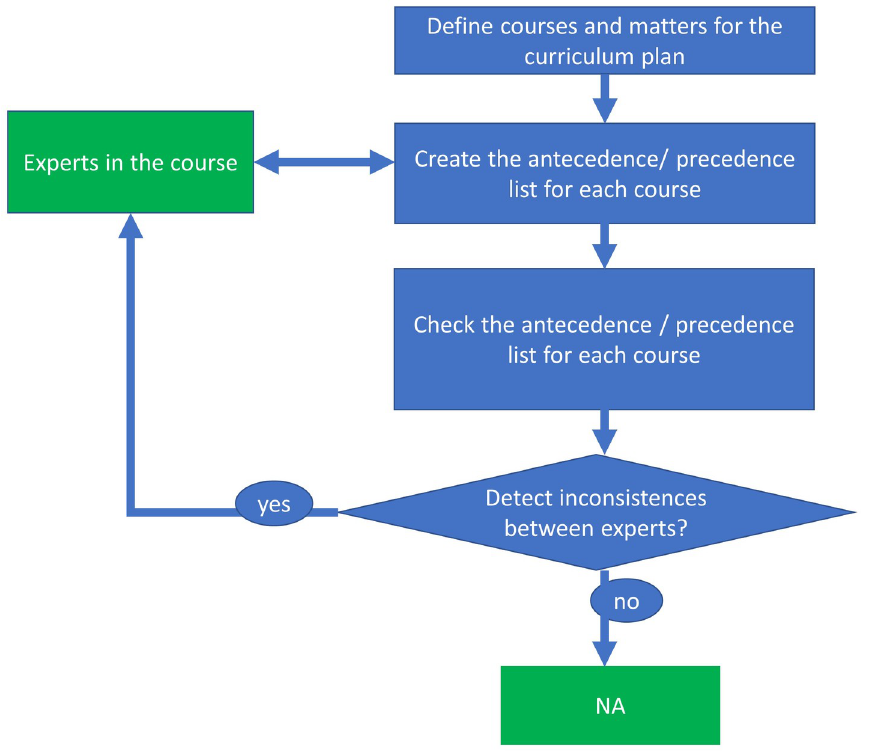
Fig 2. Decision aid model for the curriculum plan